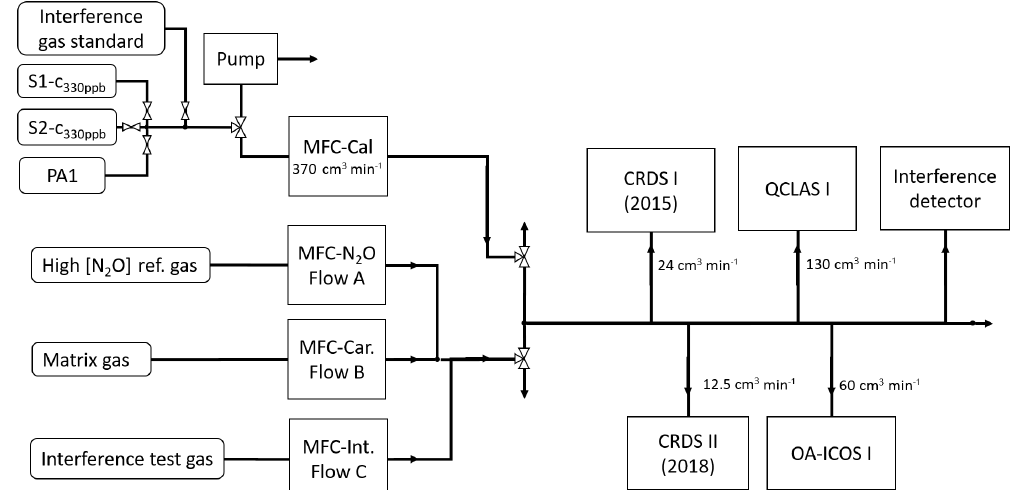
Figure 2. The generalized experimental setup used for all experiments conducted in this study. The gases introduced via MFC flows A, B and C were changed according to the experiments outlined in Sect. 2.4. Tables 2 and 3 provide the composition of the matrix gases (MFC B), interference test gases (MFC C) and high [N 2 O] concentration reference gases (MFC A). Laboratory setups for each individual experiment are provided in Sect.